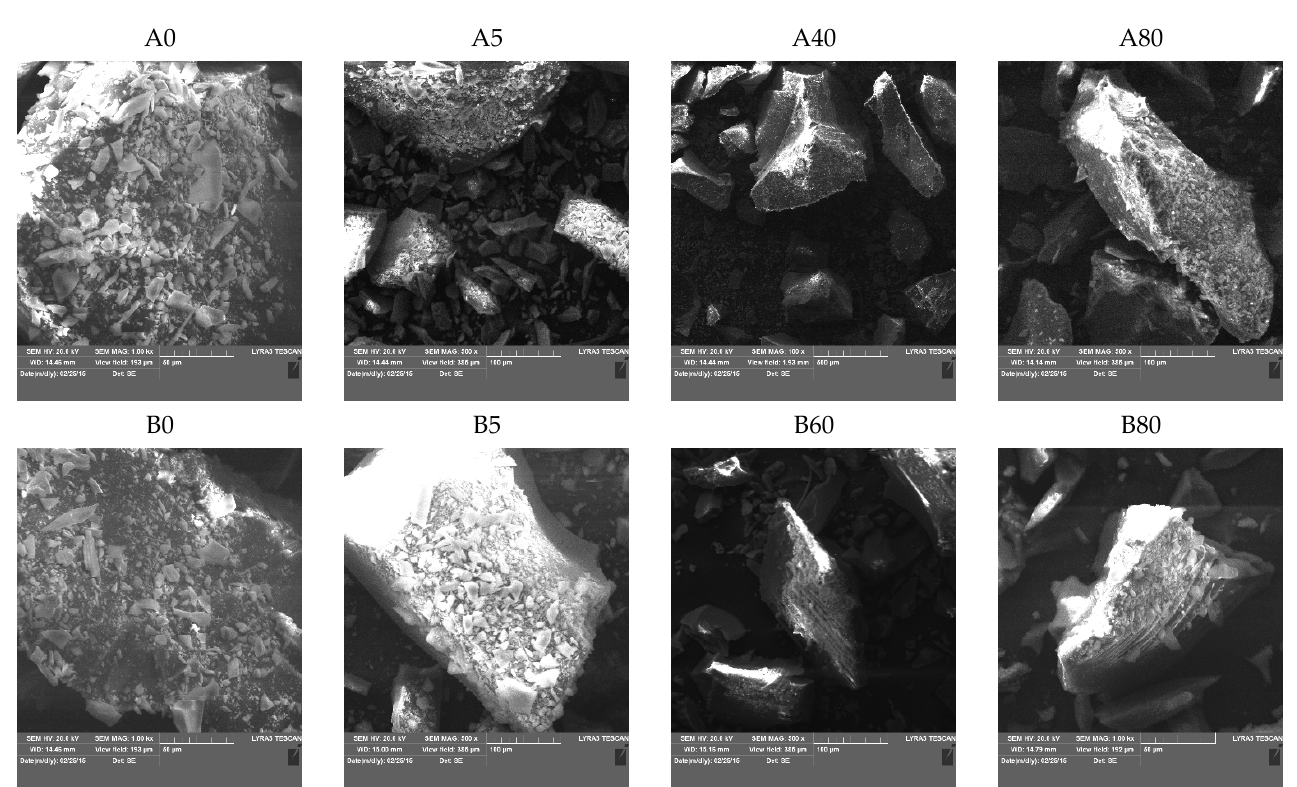
Figure 5. SEM micrographs of the hybrid silica xerogels, series A and B, obtained with different methyl substituent content (series A and series B labels represent the pH = 2.0 and pH = 4.5).